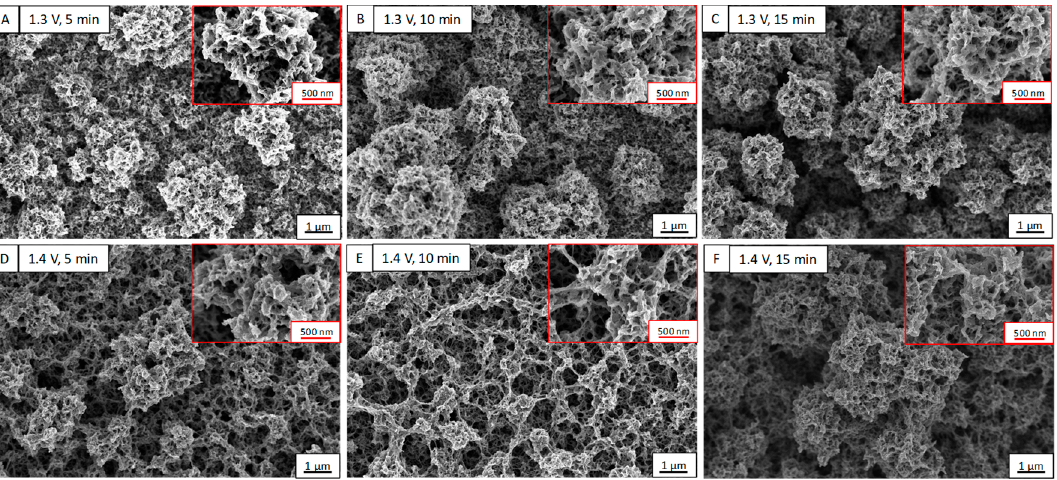
Figure 2. FE-SEM images of PEDOT films for different electropolymerization conditions, at ( A ) 1.3 V for 5 min, ( B ) 1.3 V for 10 min, ( C ) 1.3 V for 15 min, ( D ) 1.4 V for 5 min, ( E ) 1.4 V for 10 min, and ( F ) 1.4 V for 15